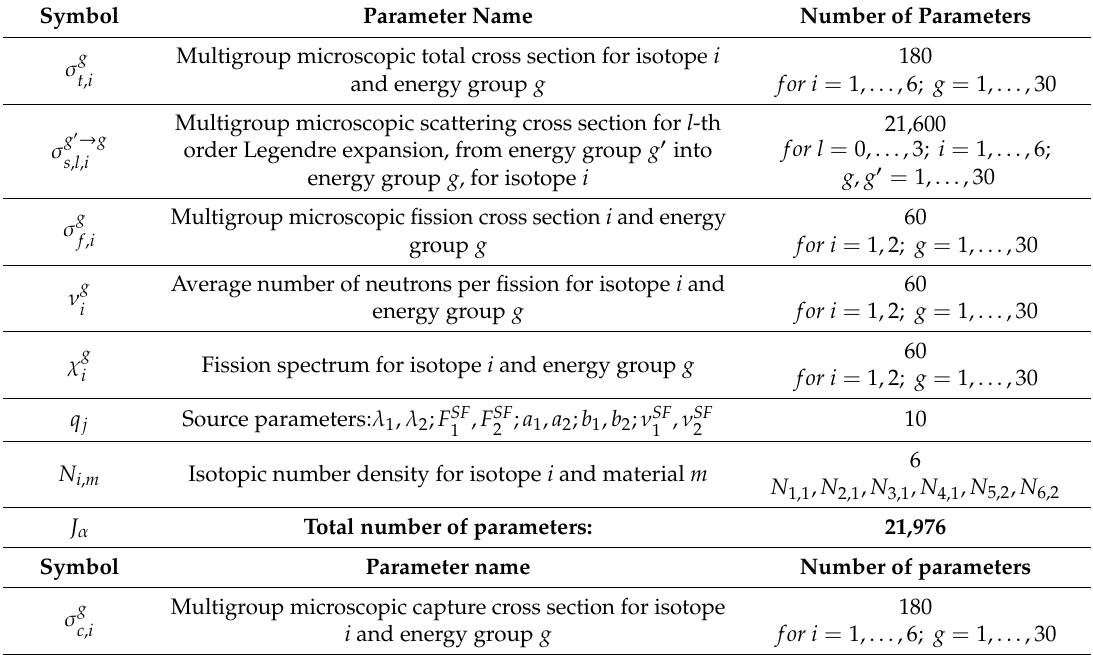
Table 3. Summary of imprecisely known parameters for the PERP